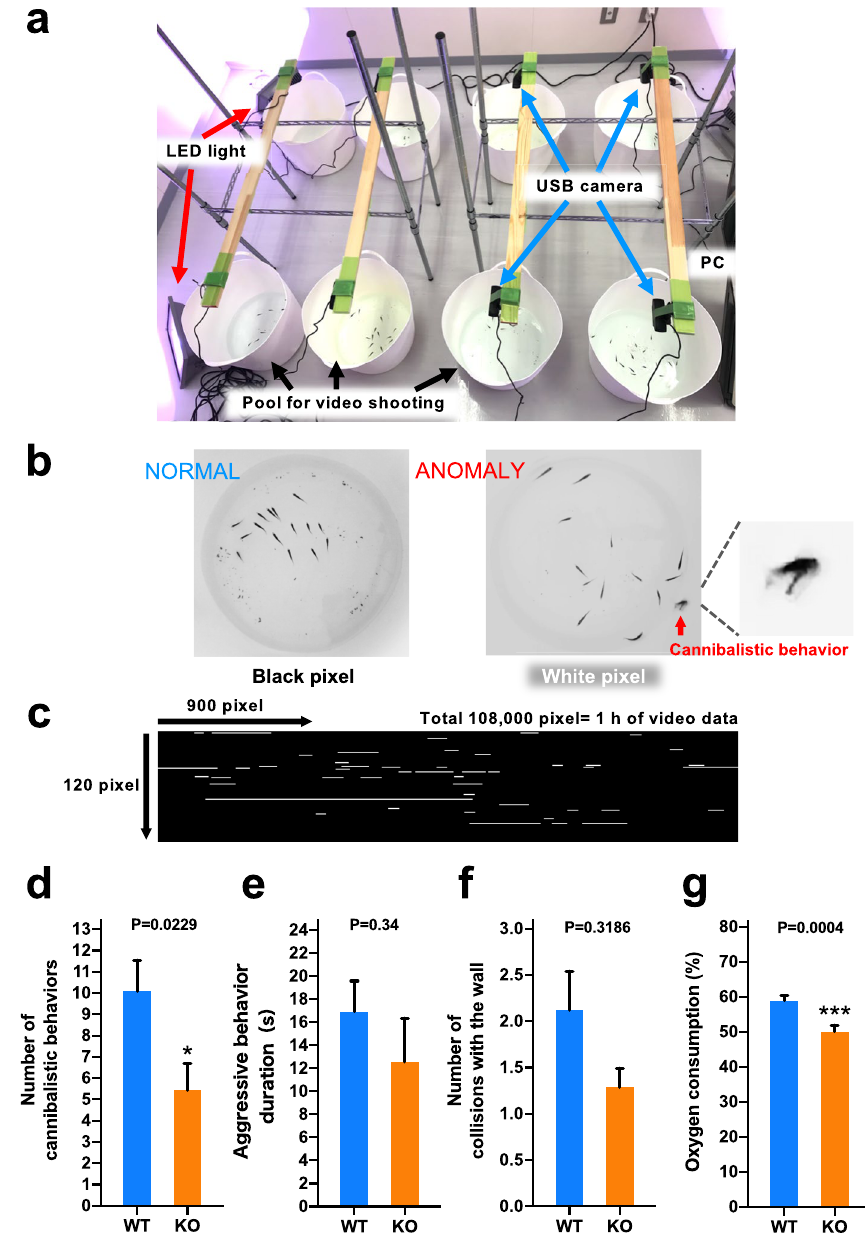
Figure 5. Phenotypic analysis of mutants. ( a ) Video shooting environment for fry. Eight sets of video shooting containers and video cameras were prepared, such that video could be shot simultaneously in all eight containers. A white, smooth, circular container (LB-4139; Nitori, Hokkaido, Japan) with a diameter of 35 cm and high contrast with the color of the back of the fry was used to capture their swimming image. A USB video camera (HD Pro Webcam C920r; Logicool, Tokyo, Japan) with a 30-fps frame rate and 1280 × 720 image resolution, connected to a PC, was attached to the upper part of each pool, and video was recorded. ( b ) Normal swimming behavior of fry (right) and the moment of cannibalistic behavior, in which the group of fry is disturbed (left). ( c ) One example of the analysis result screen of the software; 900 pixels are lined up horizontally and 120 pixels are lined up vertically. One pixel is one frame of a moving image divided into one still image frame every 1/30 s, and 108,000 frames resulted from moving image analysis for 1 h. ( d ) Frequency of cannibalistic behavior per hour. *P = 0.0229. ( e ) Duration of aggression in one cannibalistic behavior. ( f ) The number of collisions with the container wall per hour. ( g ) Oxygen consumption of WT and KO fry over 2 h in the video shooting pools. ***P = 0.0004. Data are expressed as the mean ± SEM [n = 25 (WT) and 21 (KO)] and were analyzed by unpaired two-tailed Student’s t-test followed by an f-test. WT wild type, KO